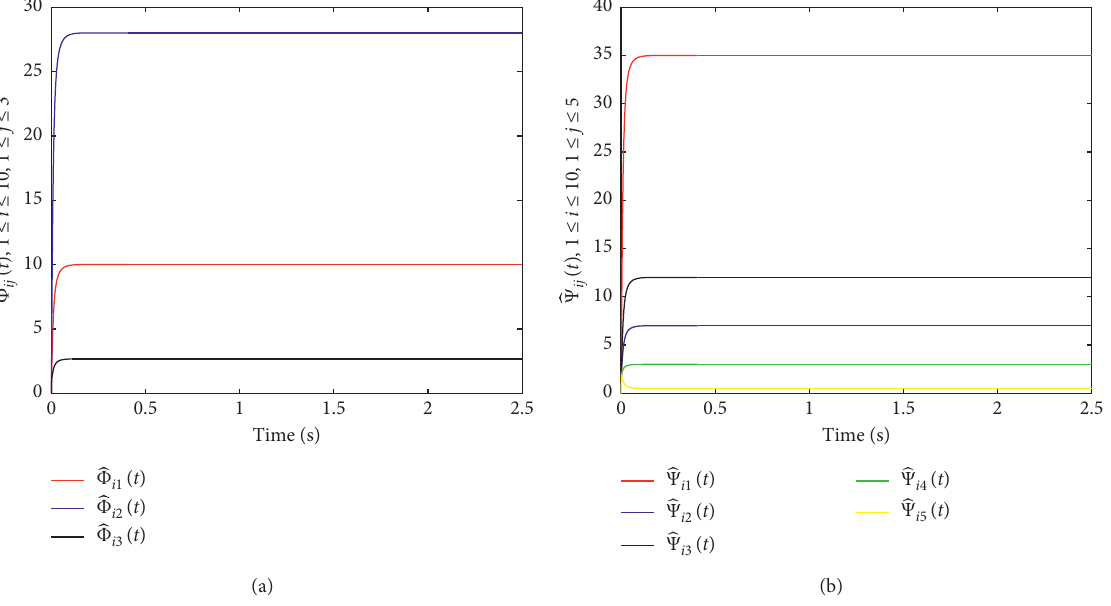
Figure 6: The estimations of unknown parameters for systems (35) and (36) by controller (25). (a) 􏽢 Φ 􏽢 Ψ ( t )( i � 1 , 2 , ... , 10 ) i